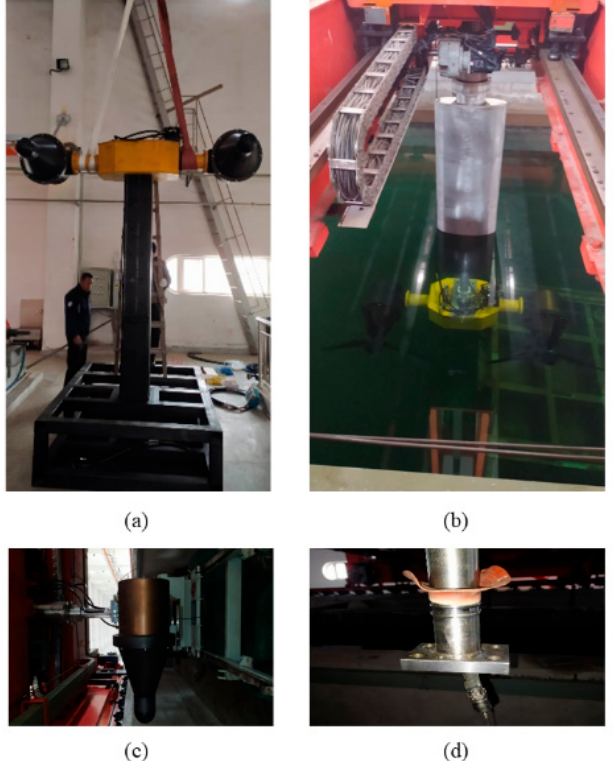
Figure 11. Pictures of the towing experiment process. ( a ) Lifting turbine; ( b ) Turbine underwater; ( c ) Fixed turbine; ( d ) Connection plate.